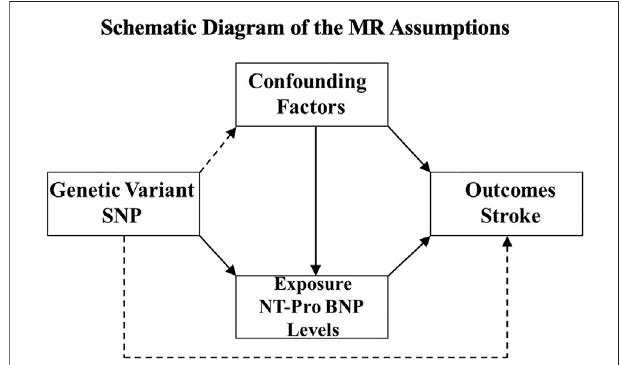
FIGURE 1 | Schematic diagram of the MR assumptions. The arrows represent possible causal associations between variables. The dashed lines represent possible causal associations between variables that would violate the MR